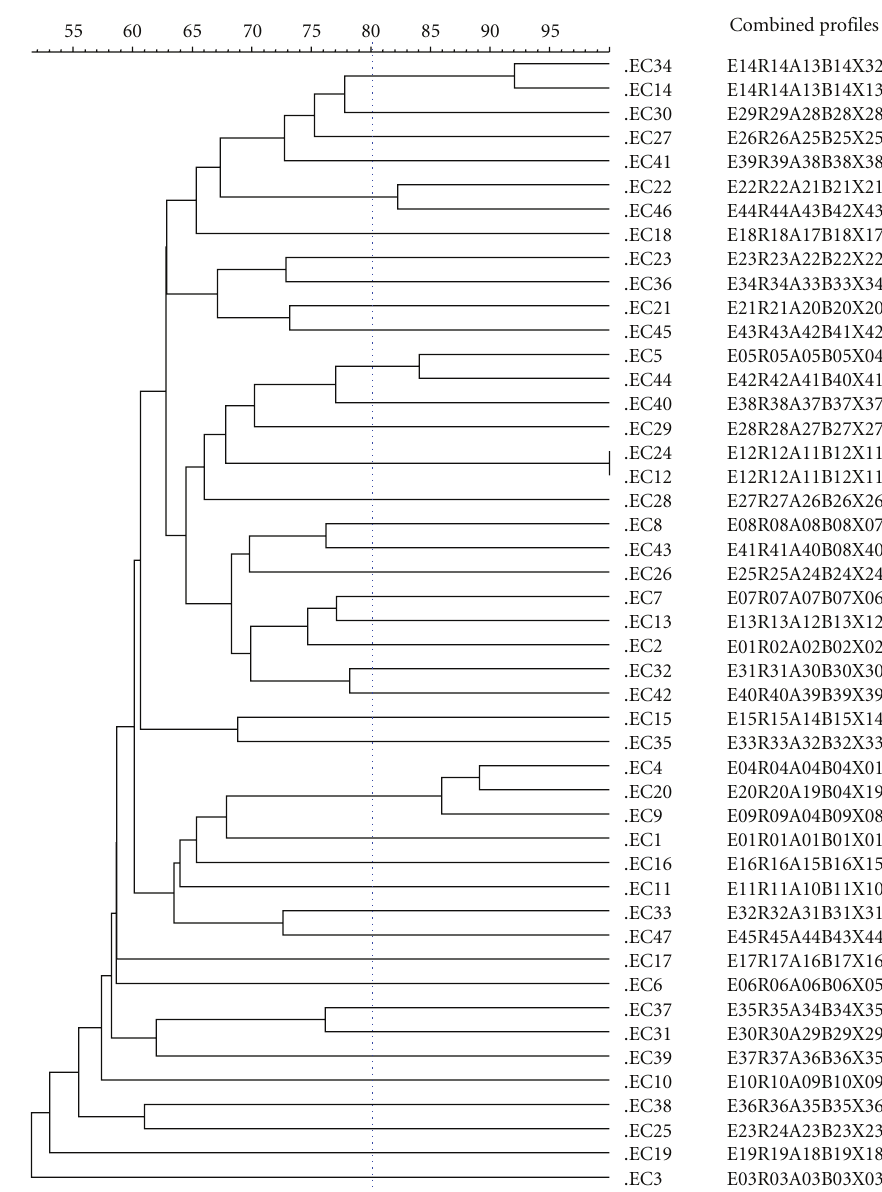
Figure 2: Dendrogram generated using UPGMA based on Dice coe ffi cients of similarity for the clustering of the E. coli combined profile. The dotted blue vertical line indicates 80% similarity